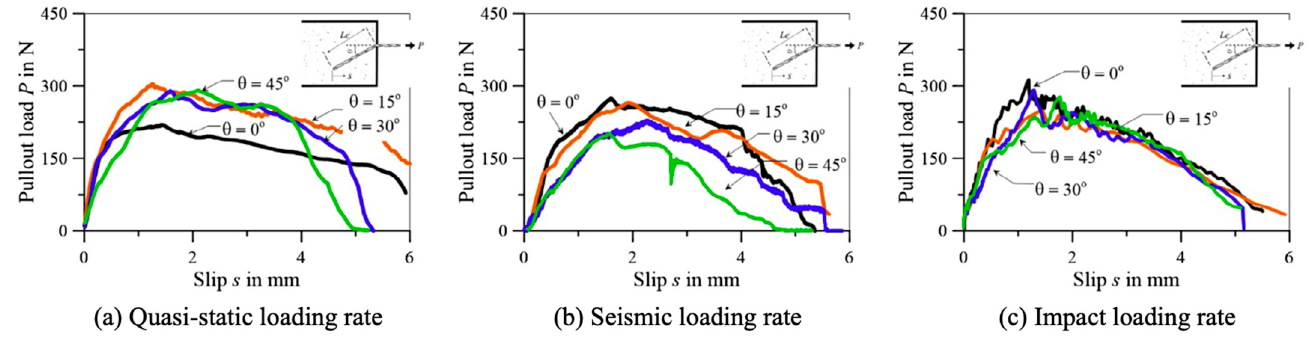
Figure 20. Average pull-out load vs. slip curves for T fibres embedded in UHPC matrix under dif- ferent loading rates and inclination angles: ( a ) quasi-static loading rate; ( b ) seismic loading rate; and ( c ) impact loading rate [26].